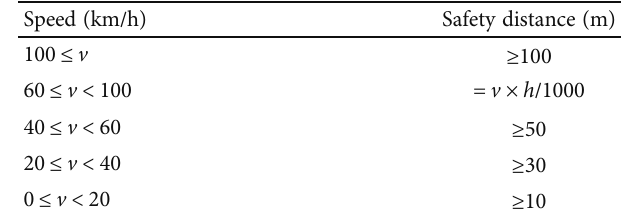
Table 1: Reference safety distances at di ff erent